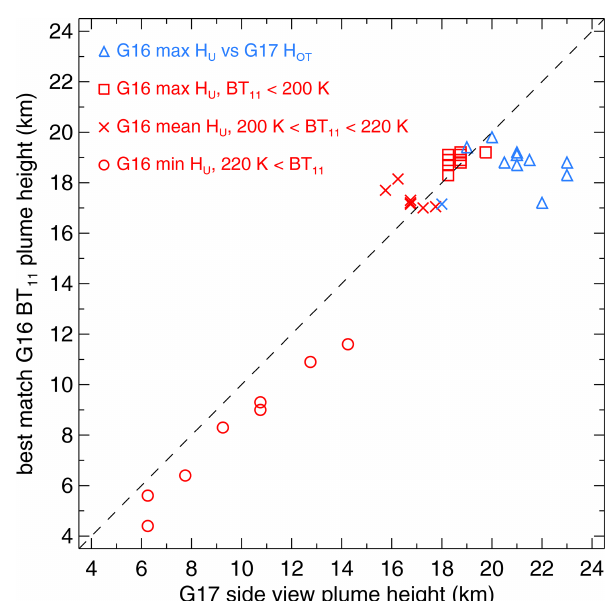
Figure 16. GOES-17 side view height versus the best-match GOES-16 temperature-based height. The GOES-17 OT height is plotted against the GOES-16 maximum (stratospheric) height so- lution. The dashed line is the 1 : 1